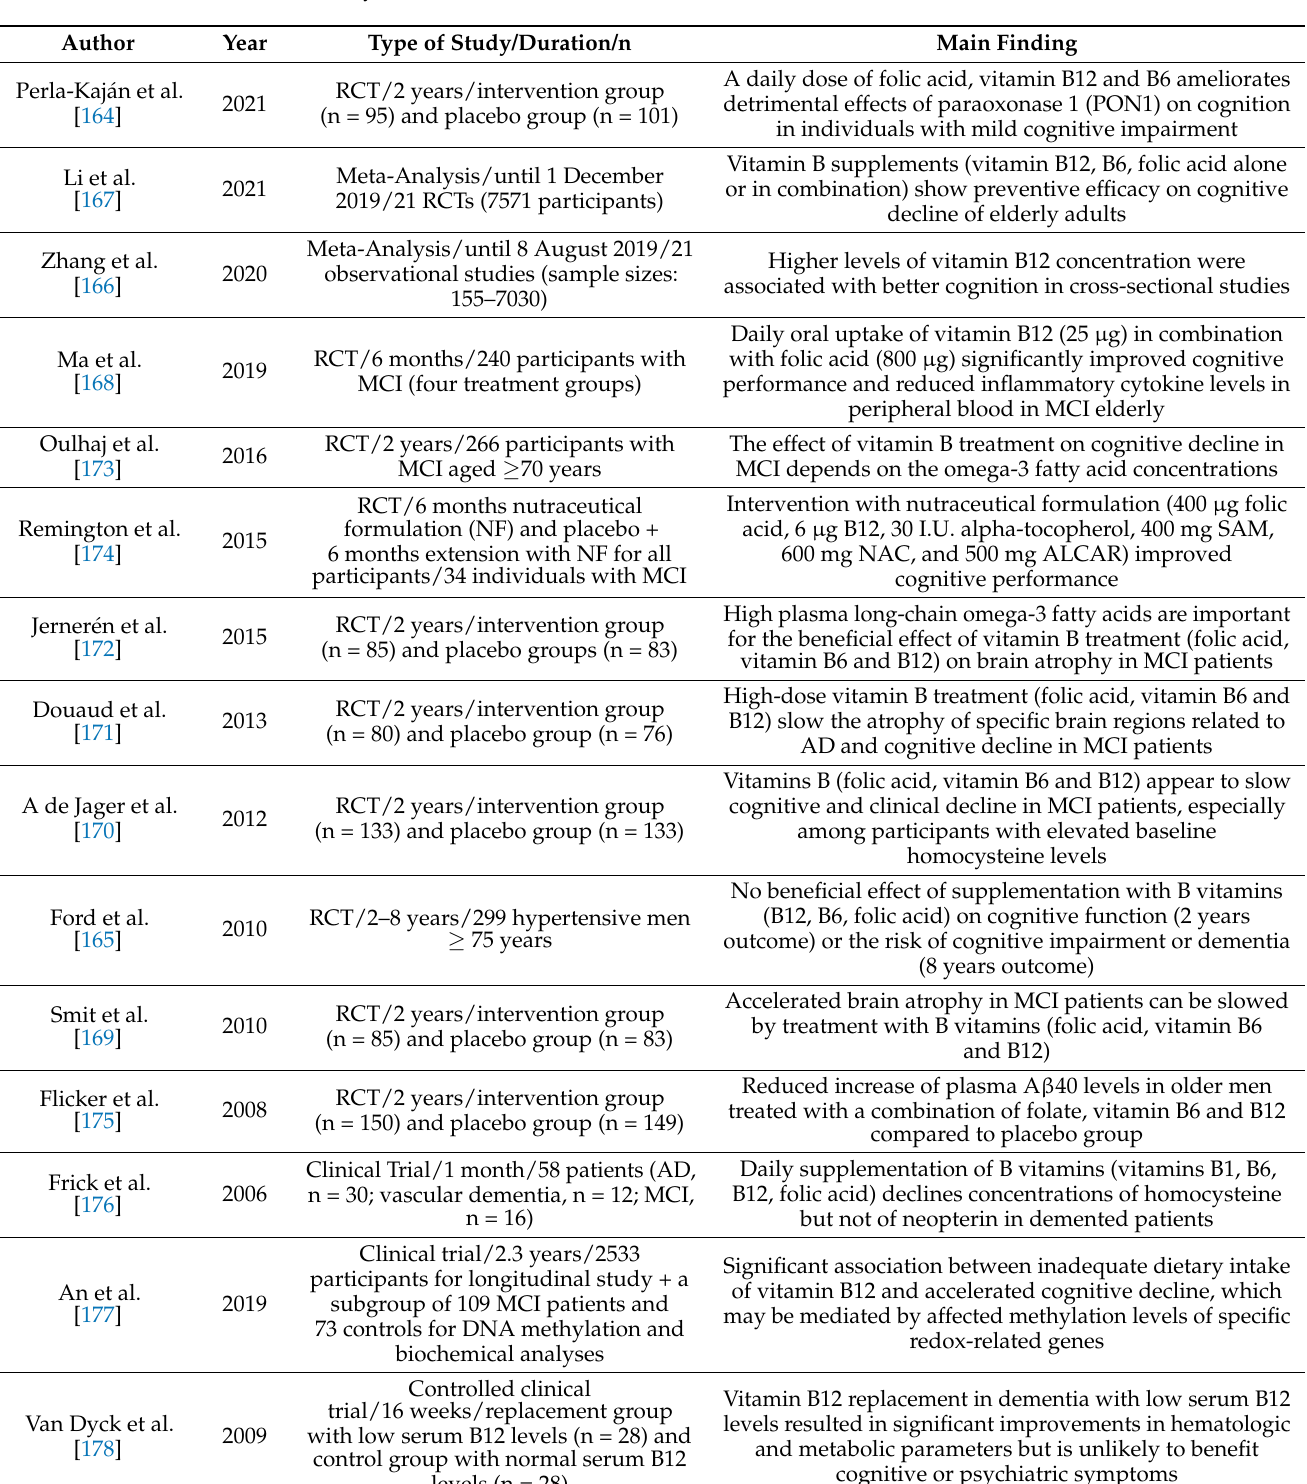
Table 1. Clinical studies examining a potential link between vitamin B12 and cognitive performance in elderly adults without cognitive impairments or MCI patients. MCI: mild cognitive impairment. RCT: randomized controlled trial. SAM: S-adenosyl methionine. NAC: N-acetyl cysteine. ALCAR: